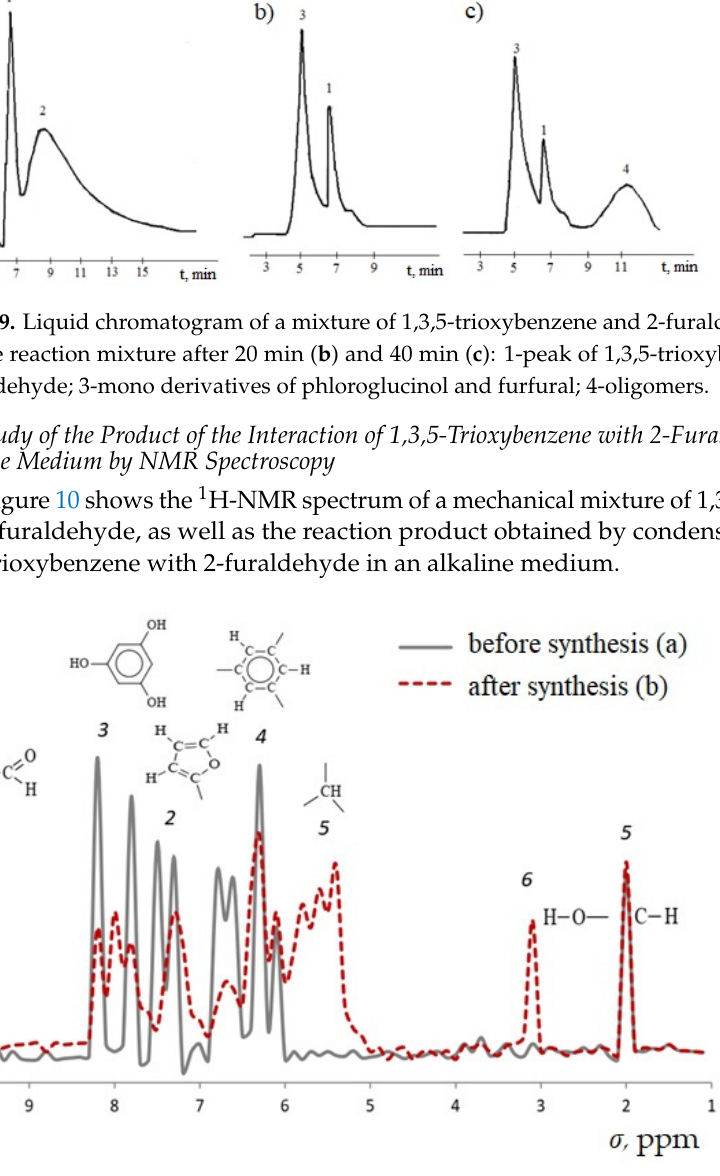
Figure 10. 1 H-NMR spectra ( a ) a mechanical mixture of 1,3,5-trioxybenzene and 2-furaldehyde; ( b ) the product of the interaction of 1,3,5-trioxybenzene with 2-furaldehyde in an alkaline medium: 1-protons of the aldehyde group of 2-furaldehyde; 2-protons of the furan ring; 3-protons of OH groups of 1,3,5-trioxybenzene; 4-protons of aromatic rings of 1,3,5-trioxybenzene; 5-methine protons (CH); 6-OH